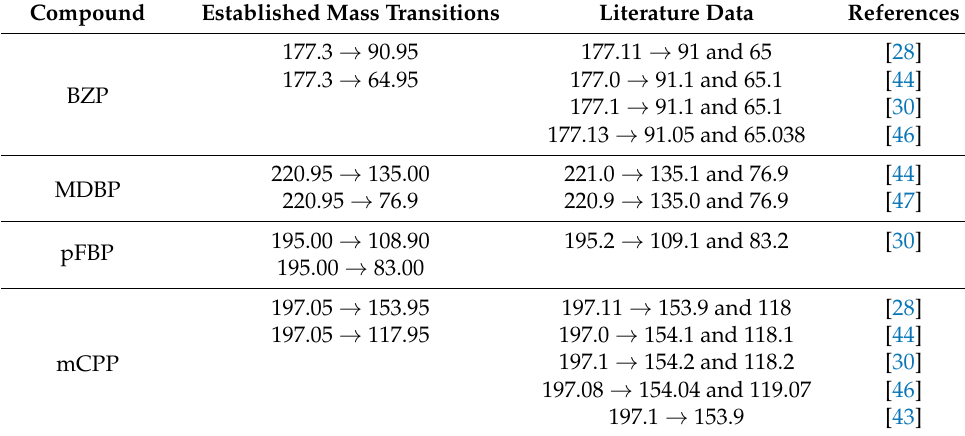
Table 5. List of MRM